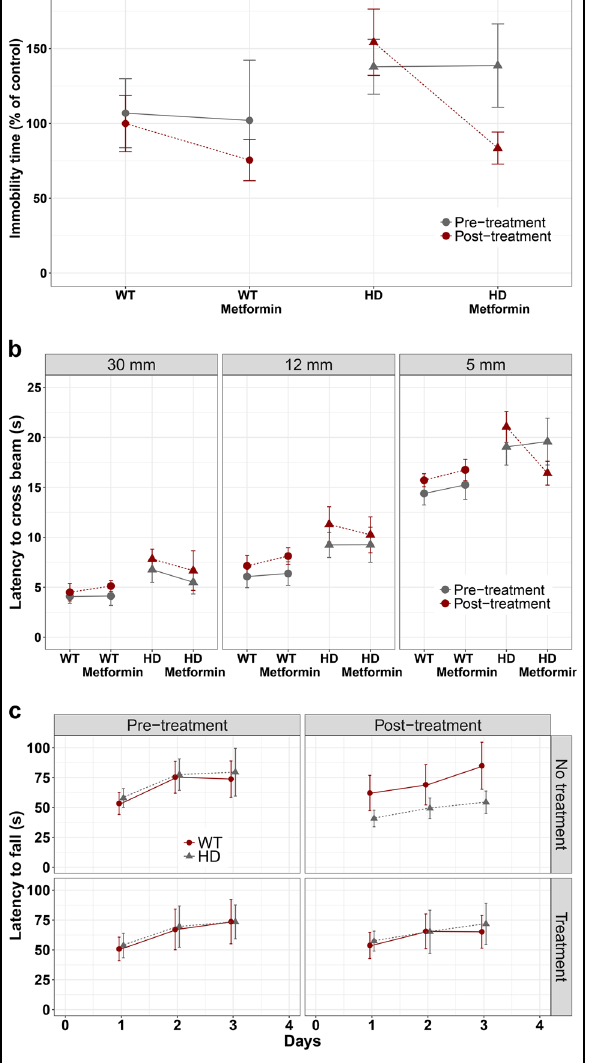
Fig. 2 Metformin treatment ameliorates the neuropsychiatric and motor behavior phenotype in heterozygous zQ175 mice. Different behavioral tests were analyzed in 3-month-old mice (pretreatment) and after 3 months of treatment (6-month-old; post treatment). a Huntington disease (HD) and control mice were subjected to the tail suspension test, and the immobility time was measured (see Materials and methods). HD mice showed a depressive state as early as 3 months of age, which was worse in 6-month-old animals. However, when the mice were treated with metformin, their depression-related behavior became similar to that in wild-type (WT) animals ( p < 0.037). b HD and control animals were subjected to the beam balance test. The time to cross each beam was recorded. HD mice exhibited dif fi culties crossing beams of different